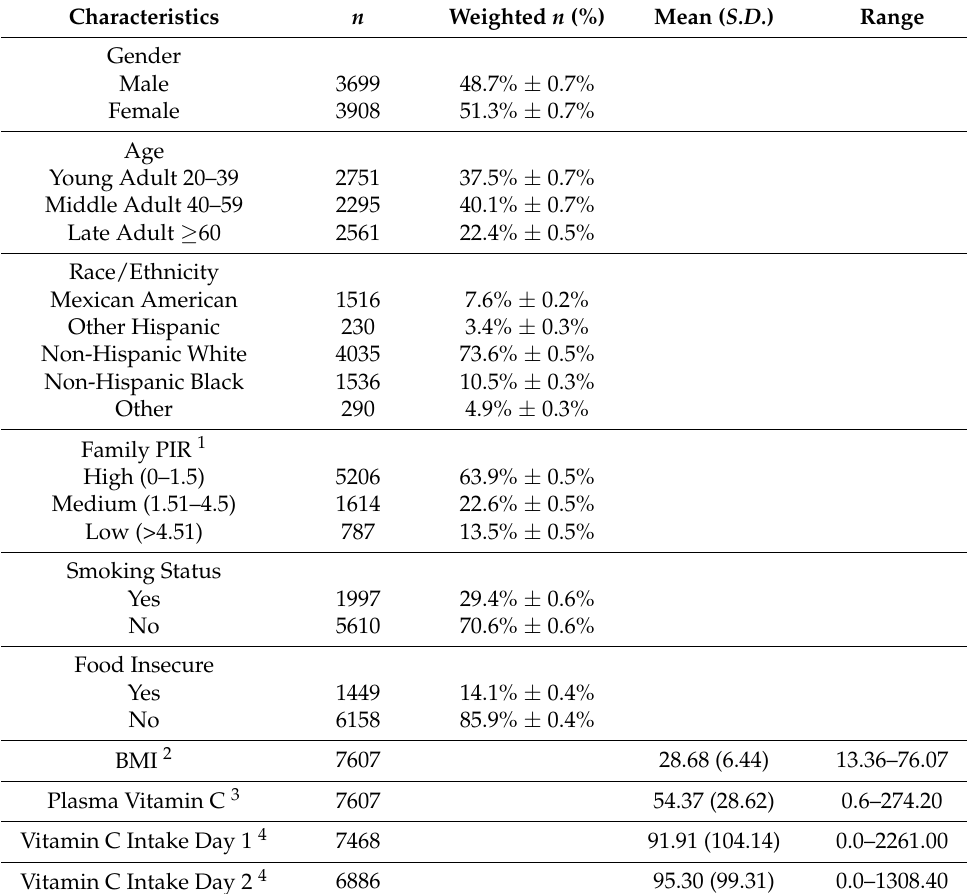
Table 1. Vitamin C Prevalence Sample Description (N =